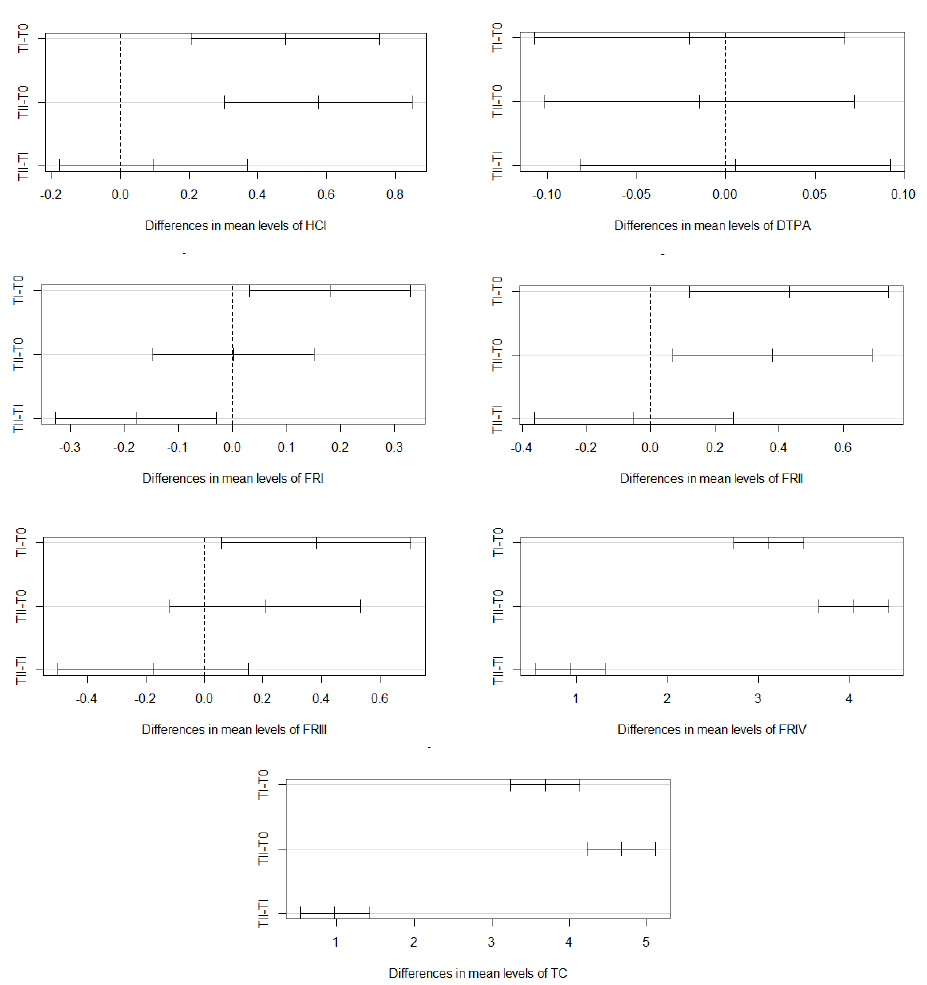
Figure 2. The 95% family-wise confidence levels for nickel amounts in soil in dependence on treatments (T0, TI, TII) and used extractant .